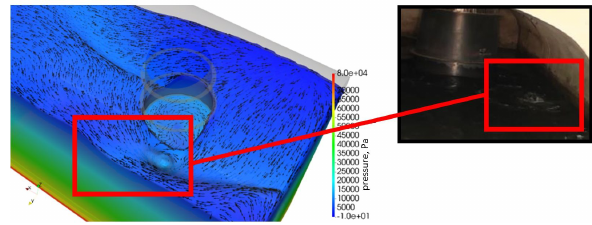
Figure 8: The water surface structure in the outlet chamber